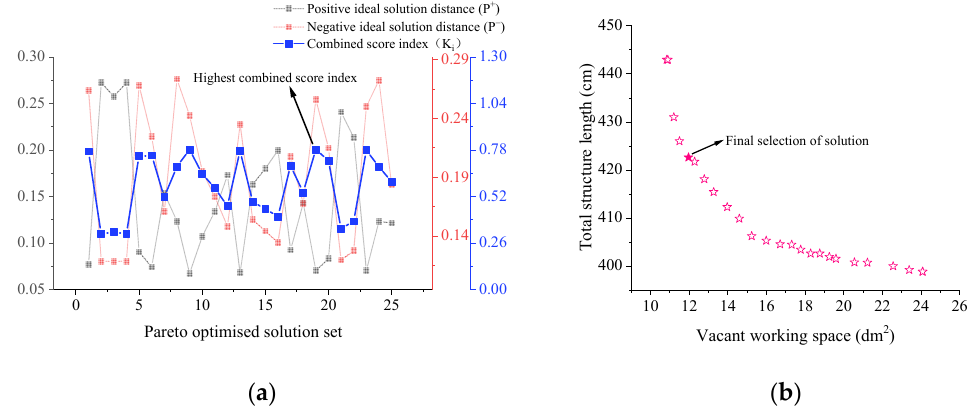
Figure 7. ( a ) Composite score index (Ki) calculated by the Pareto optimal solution set by the weighted TOPSIS method; ( b ) the position of the solution obtained by the final decision in the Pareto optimal solution set.